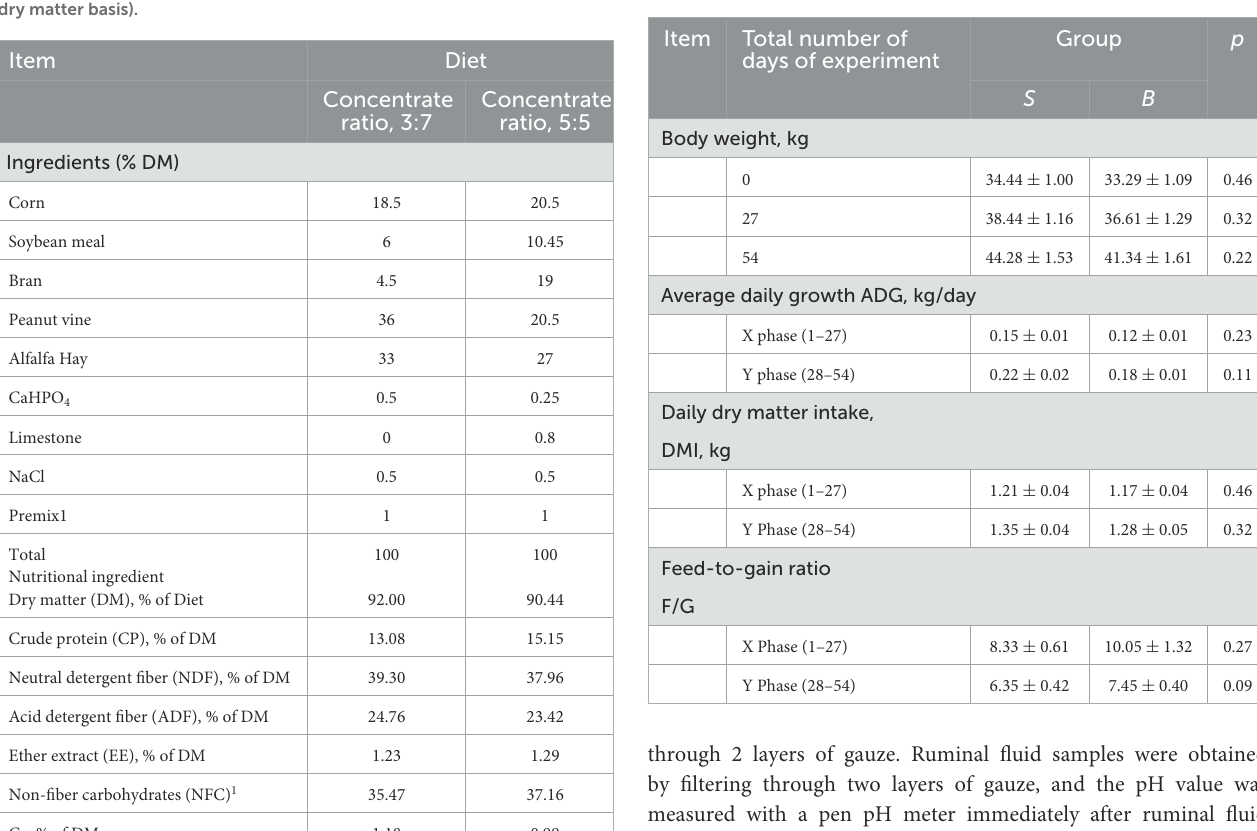
TABLE 2 Growth performance of sheep and goats fed on the same